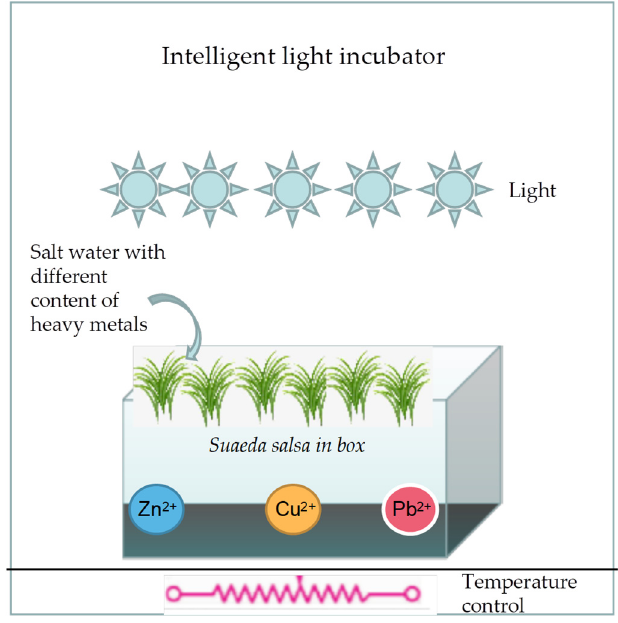
Figure 2. Graphic model of experiment.